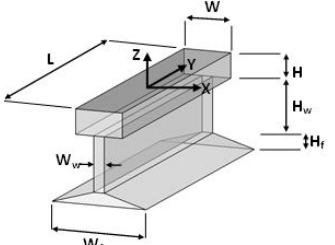
Figure 4 Rail piece coordinate system and model